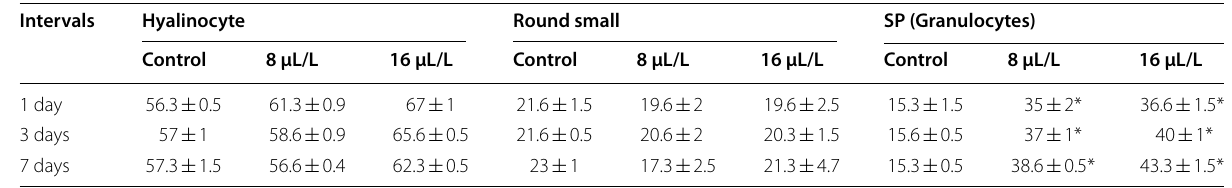
Data were expressed as mean